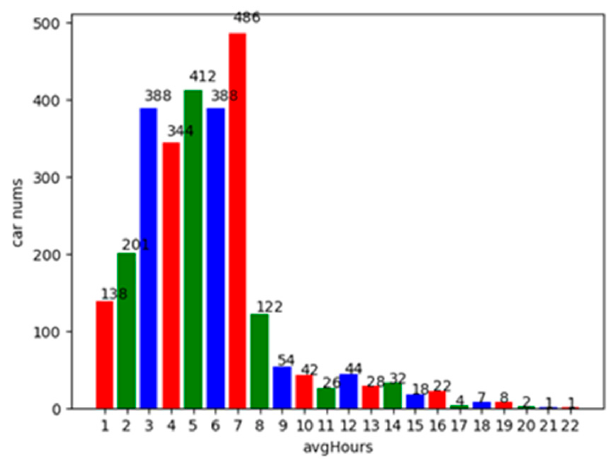
Figure 3. The distribution of average parking duration. Feature extraction is the key to data analysis. Combined with the attribute information of the data set, we select 10,000 pieces of data and extract 6 key attribute features for model analysis. These six features are vehicle code, parking lot ID number, parking order number, historical times of parking, average parking time and the longest parking duration of each parked vehicle. Through the extraction of the above features, the corresponding relationship between each vehicle and each parking lot is sorted out and 2826 new pieces